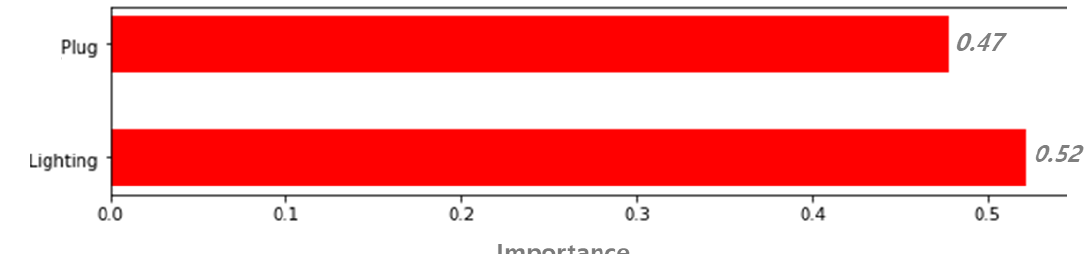
Figure 8. Gini importance of electricity energy consumption data.